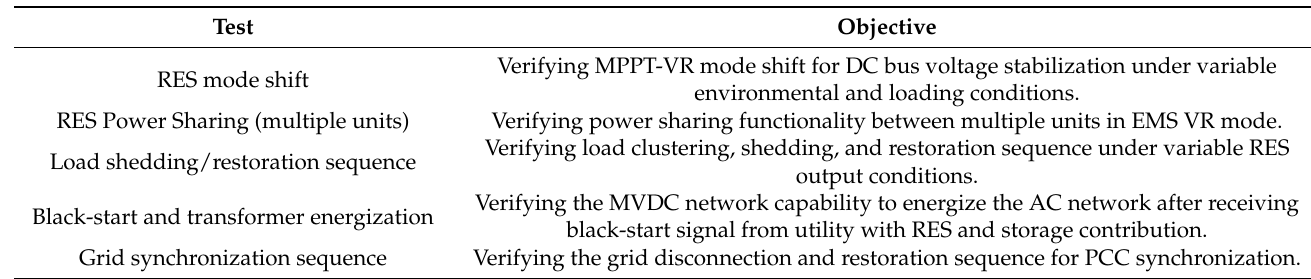
Table 1. EMS design verification